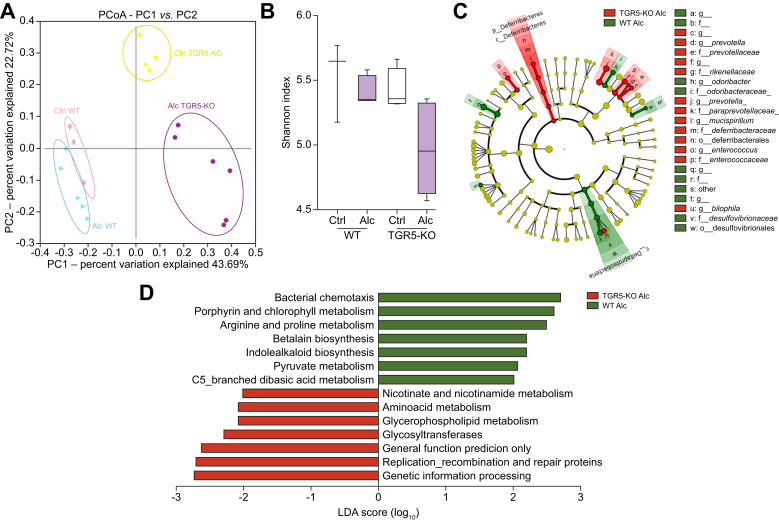
Intestinal microbiota of control and alcohol-fed WT and TGR5-deficient mice. WT and TGR5-KO mice were fed alcohol (Alc) or isocaloric maltodextrin (Ctrl). (A) Bray Curtis PCoA Unifrac distances showing a difference in the composition of the faecal microbiota between groups (p = 0.001). (B) Box plots showing alpha diversity based on the Shannon Index (Kruskall-Wallis test and Dunn’s multiple comparison post-hoc test). (C) Cladogram showing taxa with the largest differences (LDA >2) in abundance by LEfSe analysis. (D) LEfSe for the predicted metagenome metabolic pathways (KEGG modules). Only taxa with an LDA >2 and p <0.05 are shown (Wilcoxon test). WT Ctrl n = 3, WT Alc n = 5, TGR5-KO Ctrl n = 4, TGR5-KO Alc n = 6. LDA, linear discriminative analysis; LEfSe, linear discriminative analysis effect size; PCoA, principal coordinate analysis; WT, wild-type.